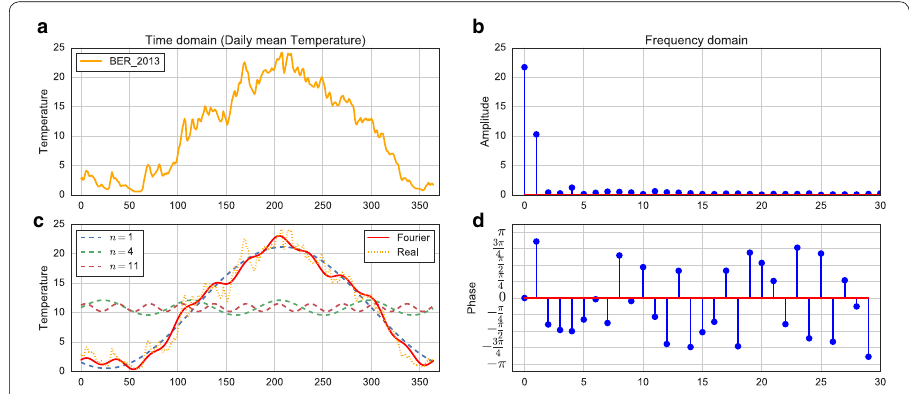
Fig. 14 Fourier analysis of a ground temperature time series example. The figure shows, for depth of 10 cm, in Bern, during the year 2013: ( a ) daily average temperature time series over the year, ( b ) and ( d ) amplitude and phase of the 30 first frequencies, ( c ) harmonics for the 3 dominant frequencies (here n n 11 ) and resulting Fourier approximation of the signal =